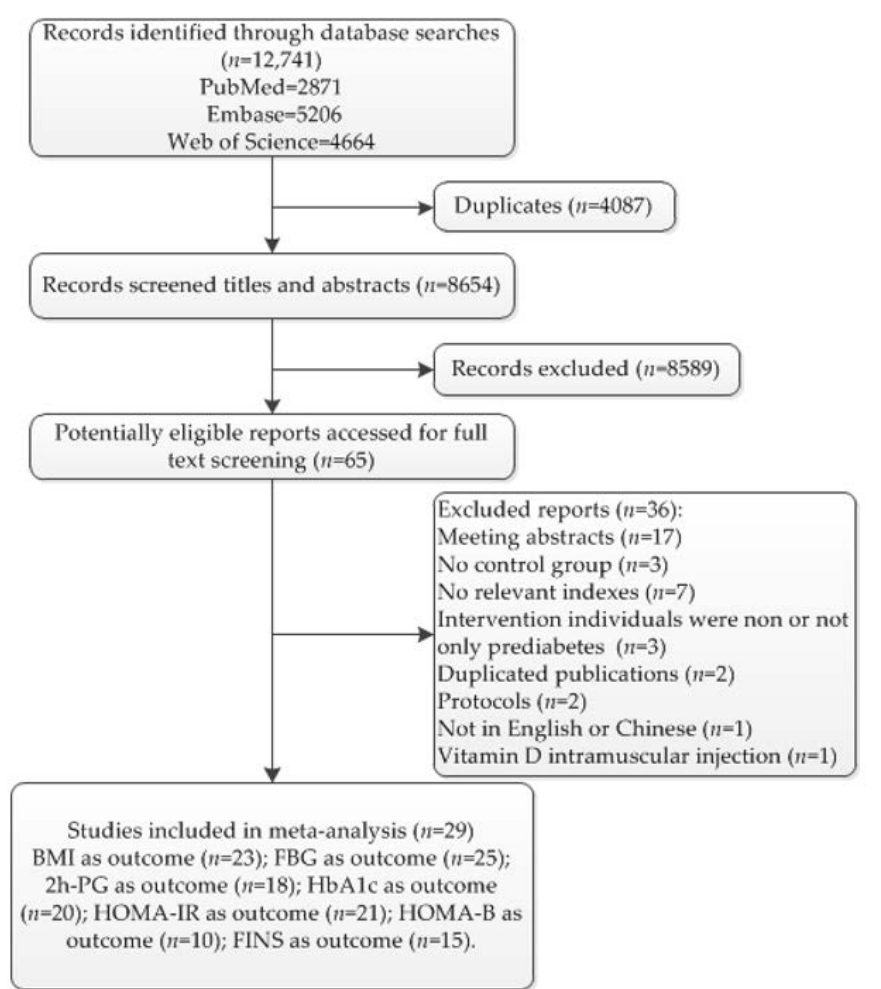
Figure 1. PRISMA flow diagram of the selected studies, indicating the used exclusion criteria. Abbre- viations: BMI: body mass index; FBG: fasting blood glucose; 2h-PG: 2 h oral glucose tolerance test plasma glucose; HbA1c: glycosylated hemoglobin A1c; HOMA-IR: insulin resistance by homeostasis model assessment; HOMA-B: homeostasis model assessment of β -cell function; FINS: fasting